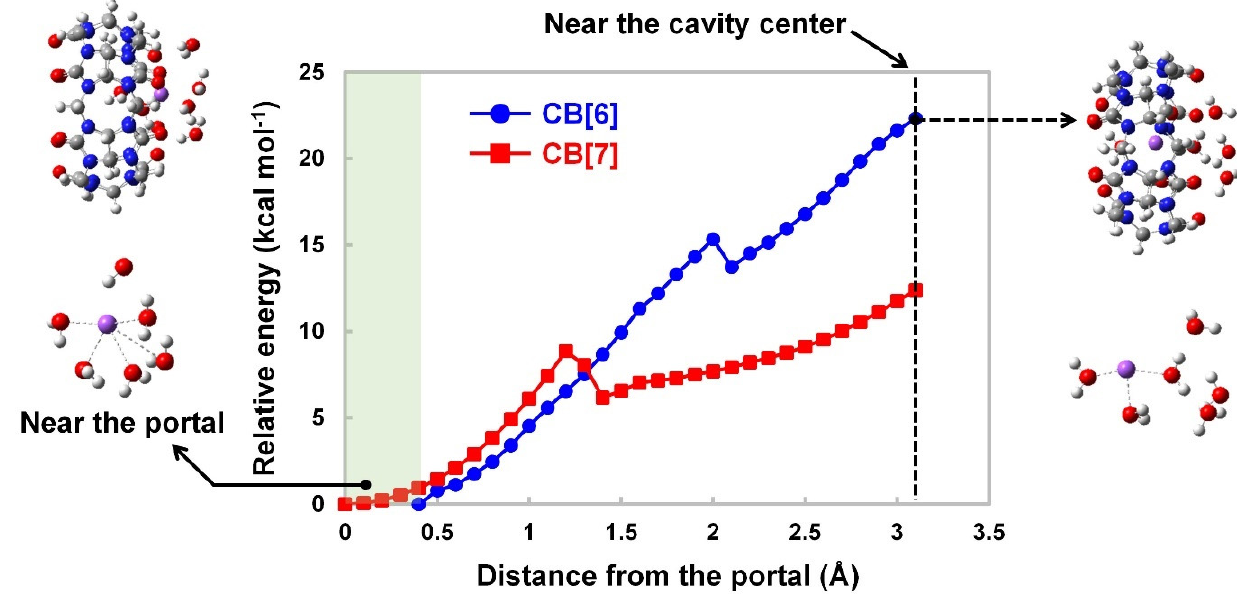
Figure 5. The CB[6]-ion and CB[7]-ion complexes’ relative energies as a function of the distance between a hydrated sodium ion and the portal. The first water shell was used to calculate the energy barrier of a hydrated sodium ion. The molecular structure of a hydrated sodium ion outside CB[6] was described on the left side, while the right illustration shows the structure in the center of the cavity (color scheme: C, grey; N, blue; H, white; O, red; Na, purple).